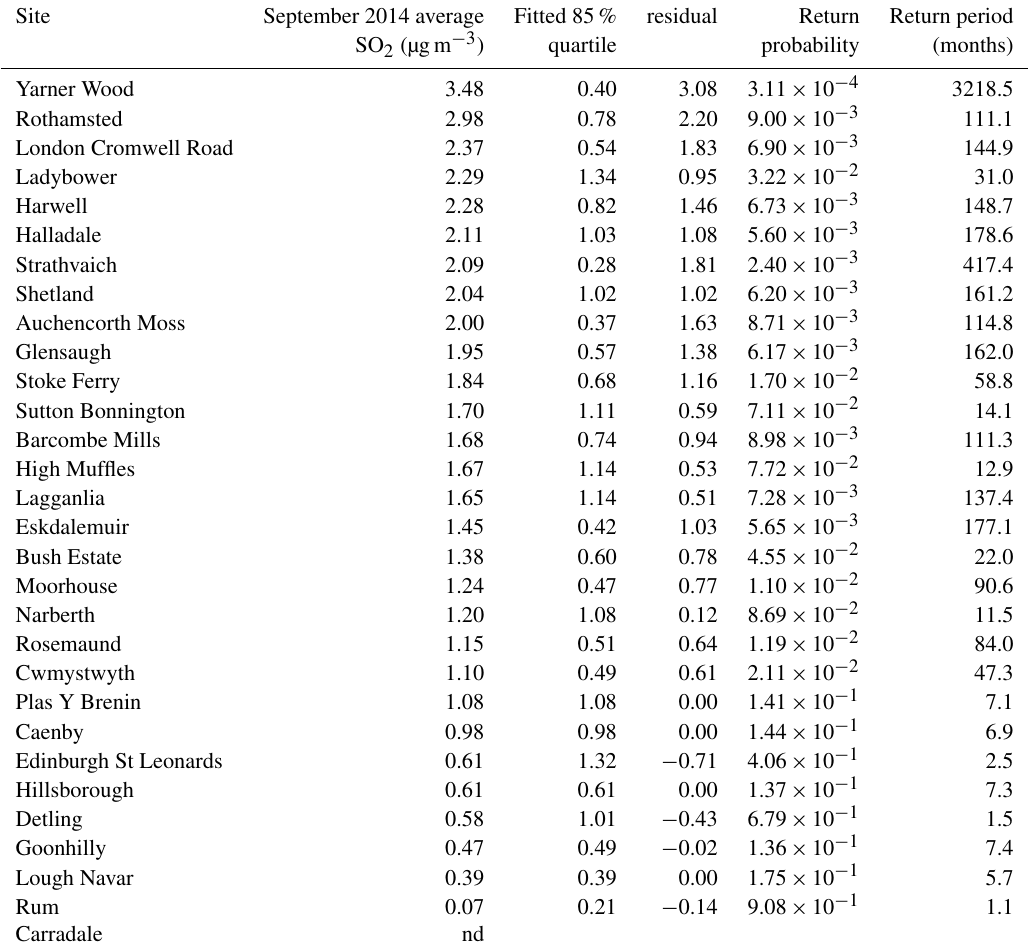
Table 1. Statistical analysis of the UK AGANET sites SO 2 (refer to Sect. 2.7 for the methods), where the return probability is the statistical likelihood of a similar concentration to be observed again based on the long-term trend of SO 2 at each site. (Refer to Fig. 1 for site locations.)